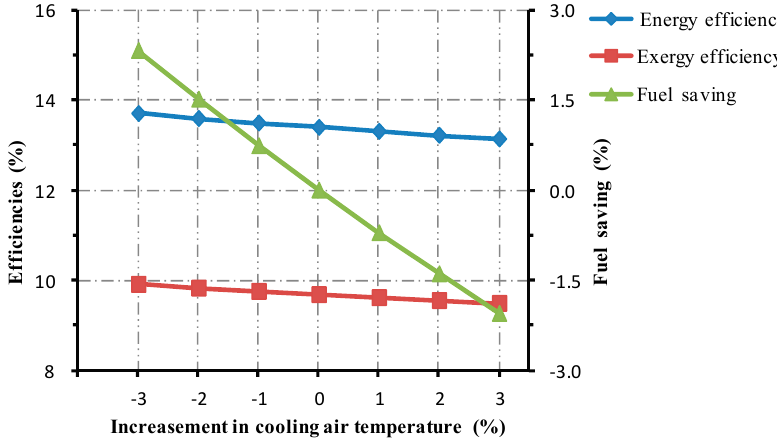
Figure 9. Impacts on energy and exergy efficiencies and fuel-saving of the roller kiln with changes in cooling air temperature.